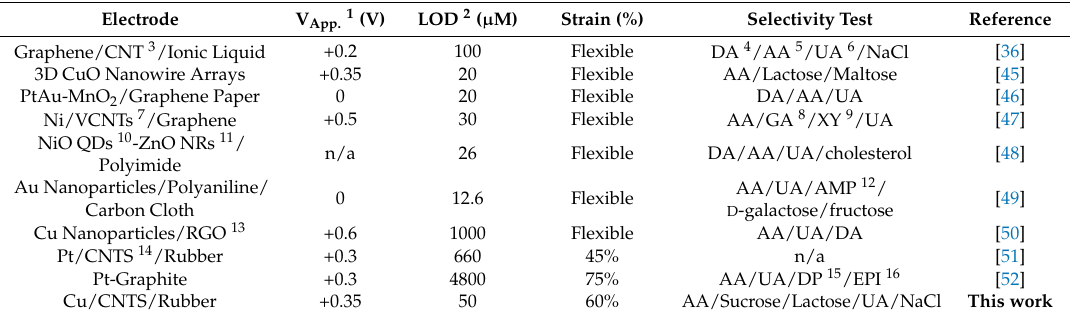
Table 1. Comparison of the non-enzymatic stretchable and flexible glucose sensing electrodes with selectivity against